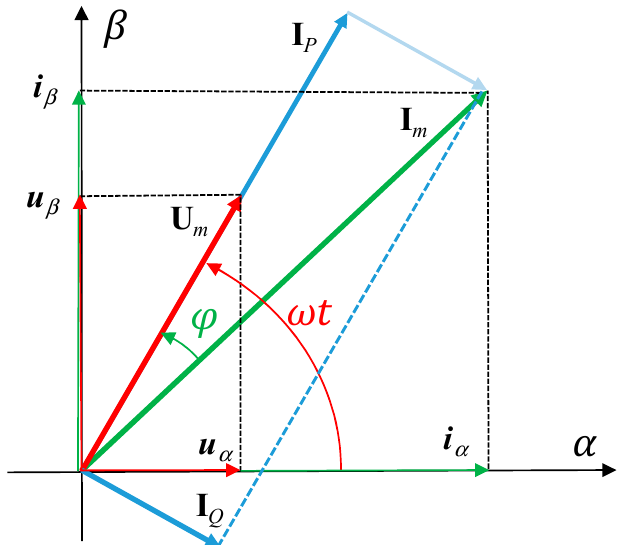
Figure 5. Graphical interpretation of reference active and reactive currents.